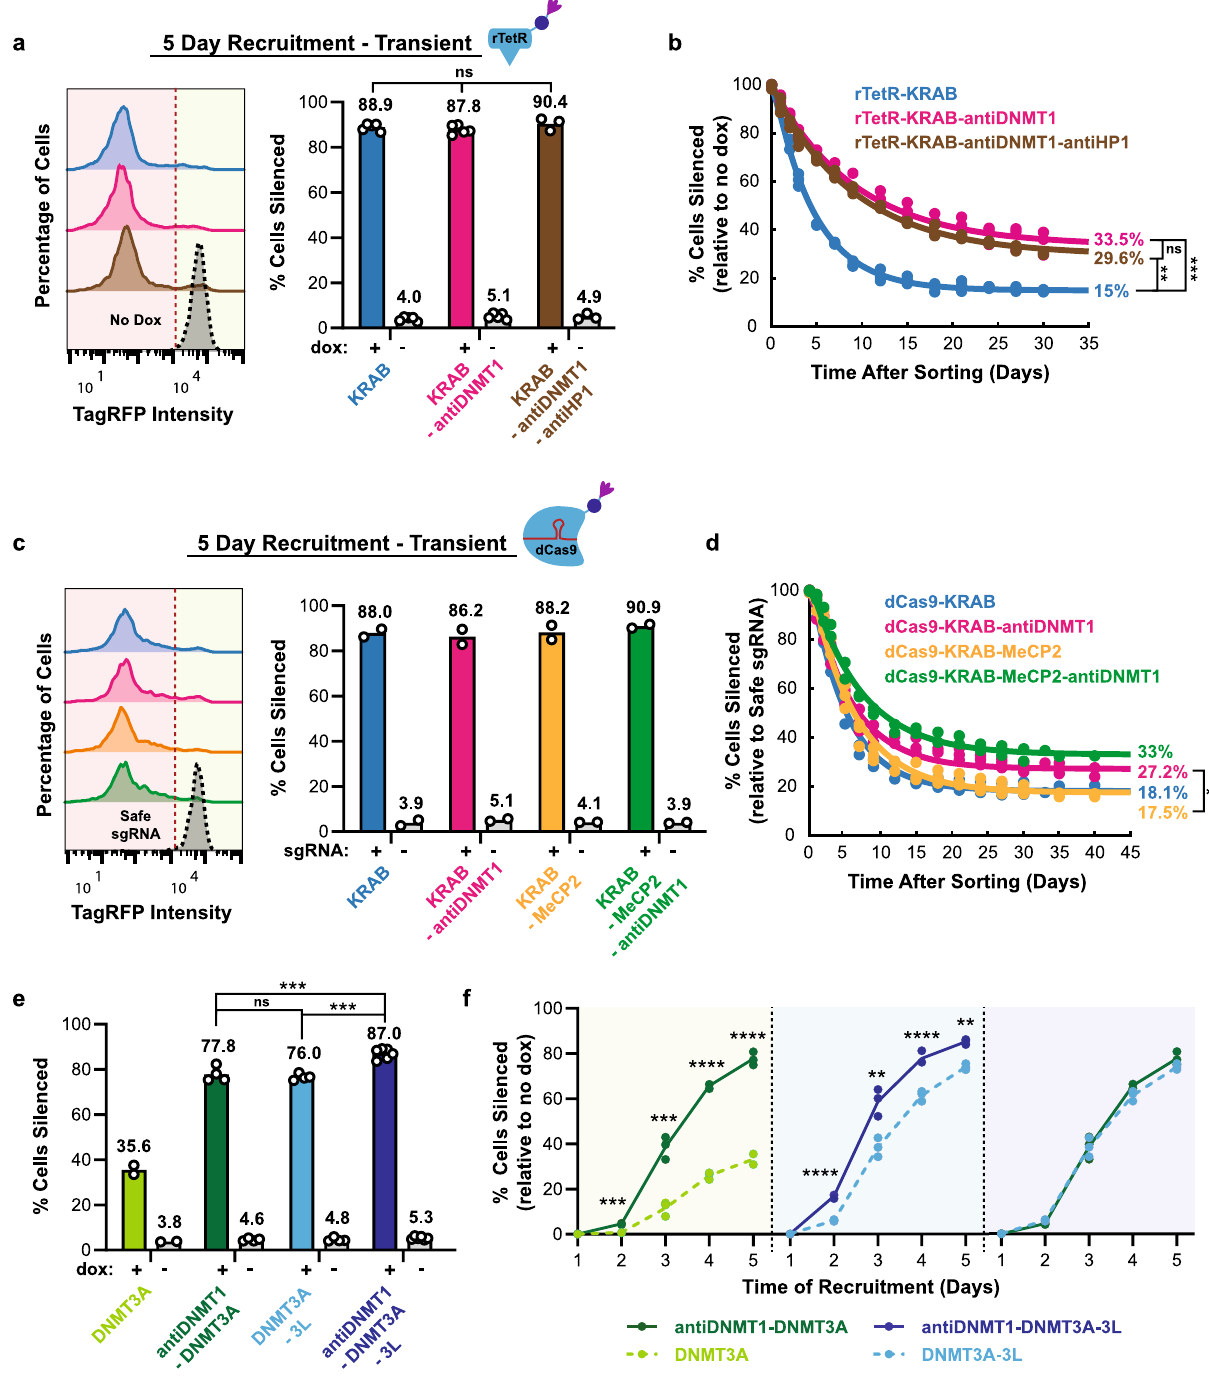
guide). When the programmable dCas9-KRAB-antiDNMT1 was targeted to the reporter gene for 5 days, there was strong silencing (Fig. 3c) and improvement in memory over dCas9-KRAB (Fig. 3d; 27.2% vs. 18.1%). Recruitment of dCas9-KRAB-antiDNMT1 not only demonstrated improved memory over dCas9-KRAB but also over a newly developed combined repressor, dCas9-KRAB- MeCP2 4 , (Fig. 3d; 27.2% vs. 17.5%). In our system, KRAB- MeCP2 has the same memory as KRAB alone (Fig. 3d; 18.1% vs. 17.5%) and the addition of antiDNMT1 to this fusion resulted in a similar improvement in memory as when added to KRAB (Fig. 3d; 33% for KRAB-MeCP2-antiDNMT1 vs. 27.2% for KRAB-antiDNMT1). These results suggest that the